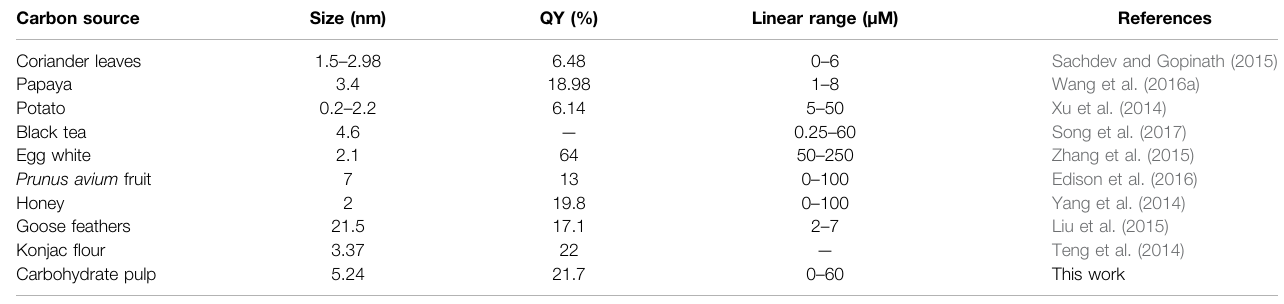
TABLE 1 | Comparison of the reported CQDs for Fe 3+ detection. Carbon source